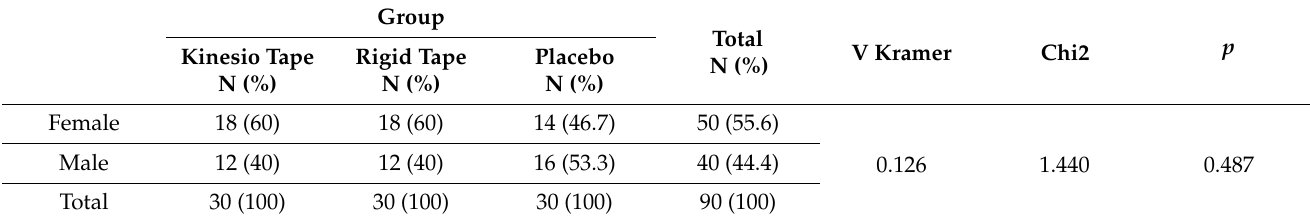
Table 1. Sex distribution in the groups under study (N = 90).